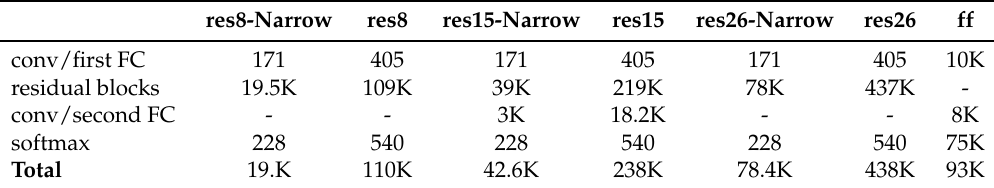
Table 2. Number of parameters in the architectures used in the experiments for the case of the Google Speech Commands dataset [14] and the log-Mel filter banks. The names of the residual networks follow [32]. FC stands for the fully-connected layer. conv stands for the convolutional layer. res8-Narrow res8 res15-Narrow res15 res26-Narrow res26 ff